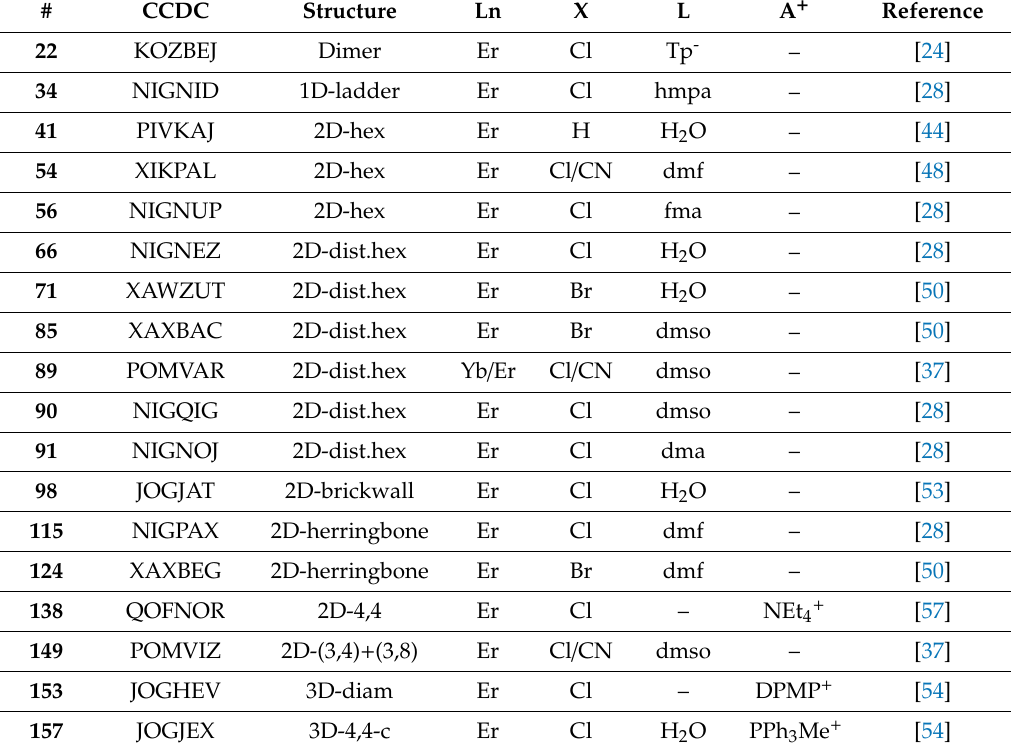
Table 24. Structurally characterized Er(III) compounds with anilato ligands.